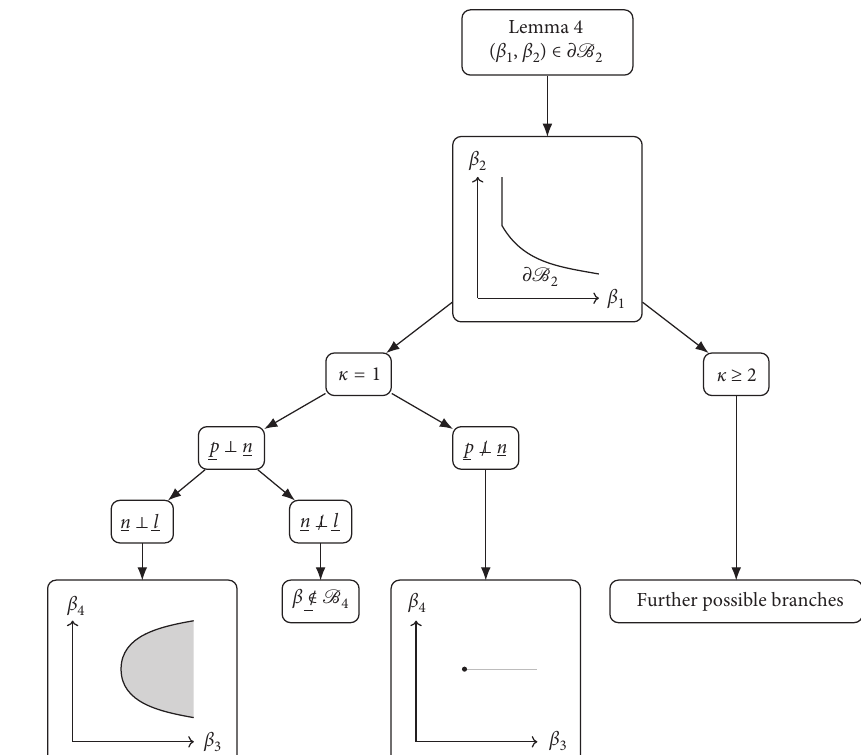
Figure 8: Illustration of cases occurring in Lemma